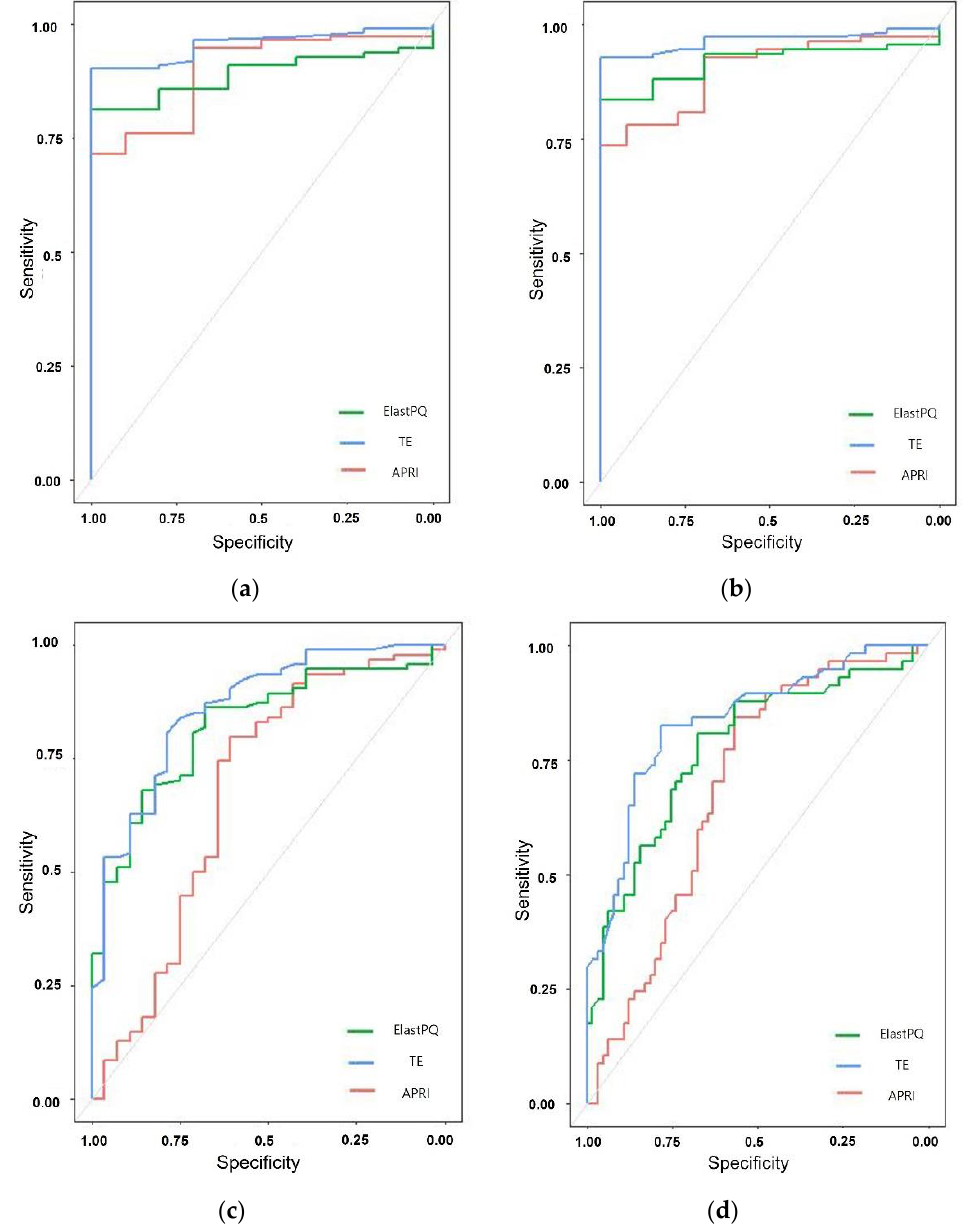
Figure 4. The receiver operating characteristic curves of ElastPQ, transient elastography (TE), and aspartate aminotransferase-to-platelet ratio index (APRI) for predicting fibrosis stage ≥ F1 ( a ) , ≥F2 ( b ) , ≥F3 ( c ), F4 ( d